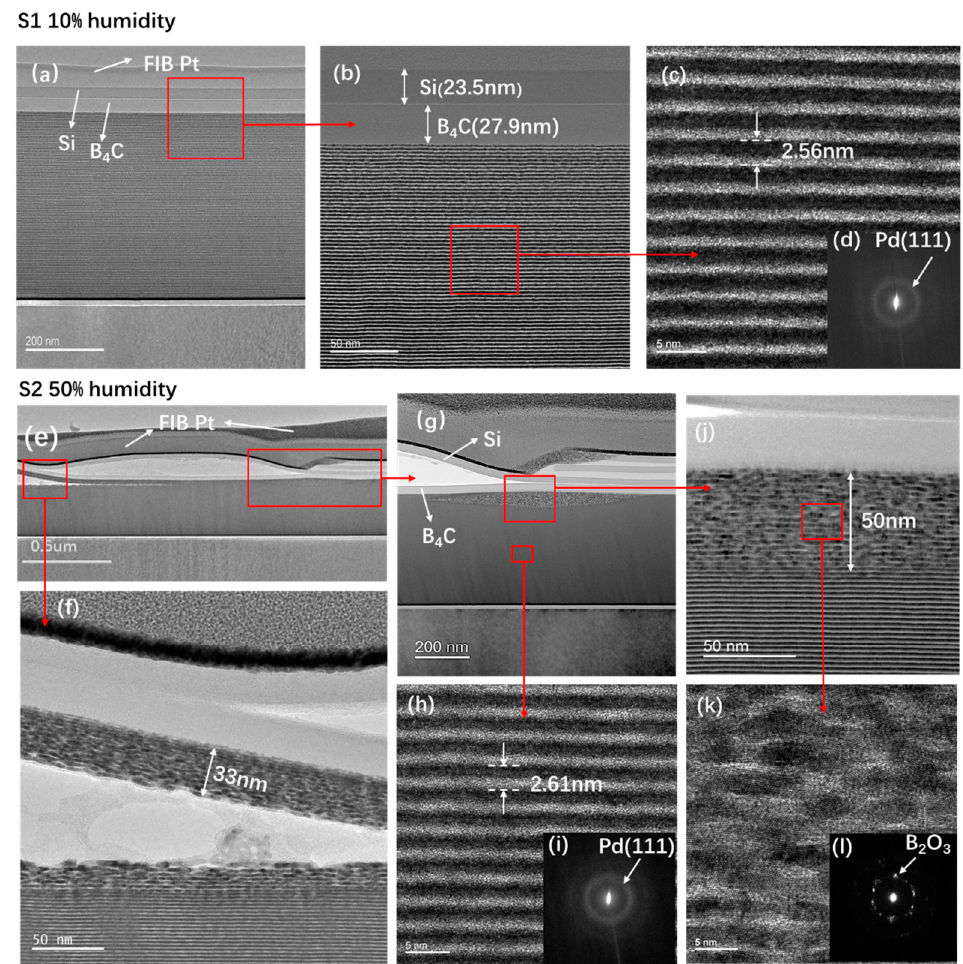
Figure 5. Transmission electron microscopy (TEM) and selected area electron diffraction (SAED) images of the Pd/B 4 C multilayers stored at 10% humidity and 50% humidity after 13 months. Figures ( a – d ) are the S1 sample at 10% humidity, whereas Figures ( e – l ) are the S2 sample at 50% humidity.